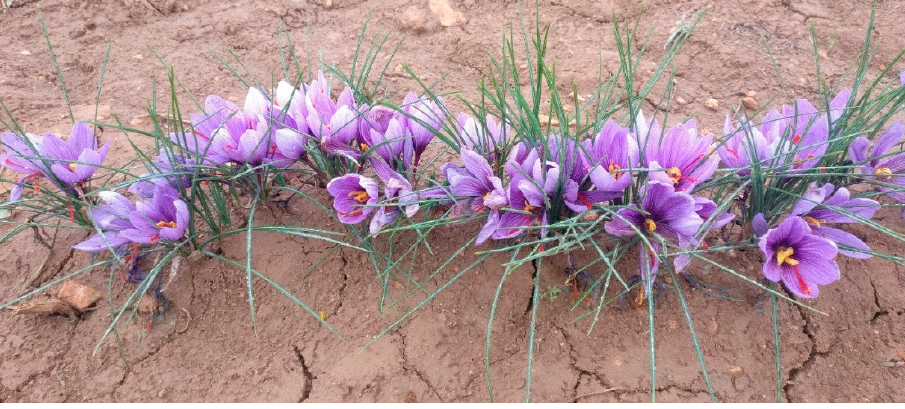
Figure 1. Plant of Crocus sativus L.